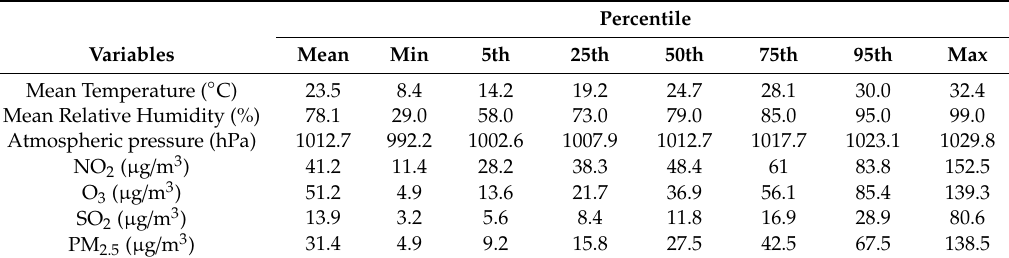
Table 1. Descriptive statistics of metalogical and air pollutant variables.